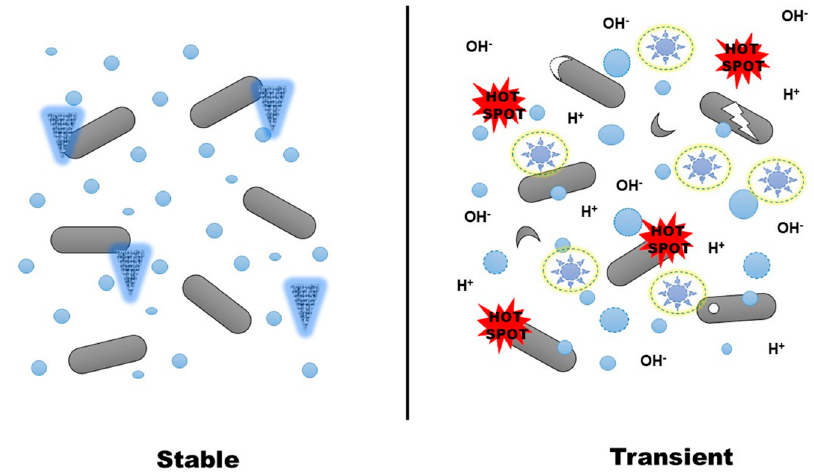
Figure 1. Comparison between stable and transient cavitation during ultrasound processing. In “stable cavitation,” bubbles grow and dissolve, and micro eddies are formed. In “transient cavitation,” bubbles grow and collapse violently, there is sonoluminescence, generation of hot spots and free radicals (OH − , H + ), and breakdown of macromolecules.